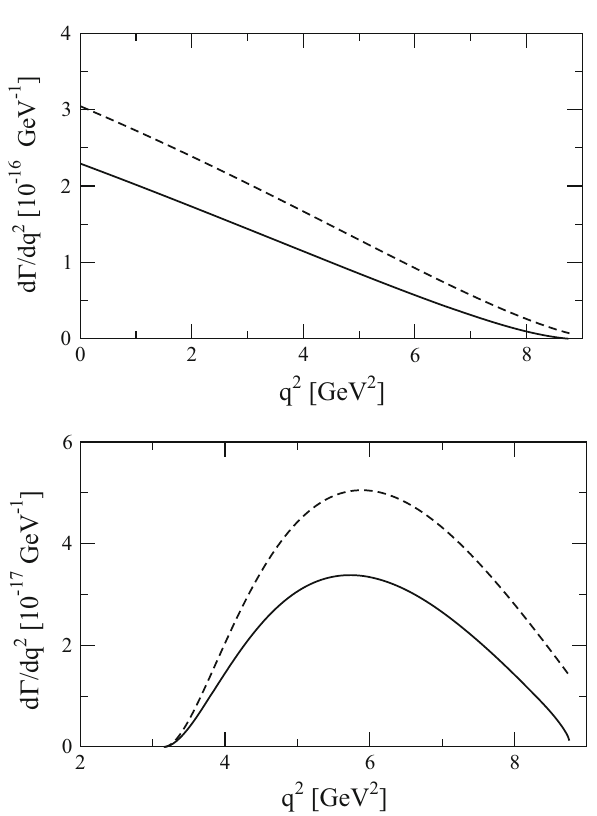
Fig. 1 The differential decay rate d (cid:15)/ dq 2 as a function of momentum transfer q 2 . In the upper plot, the solid and dashed line indicate B + → ( 2400 ) e + ν → D ∗− ( 2317 ) e + ν D ∗ e and B s e , respectively, while s 0 0